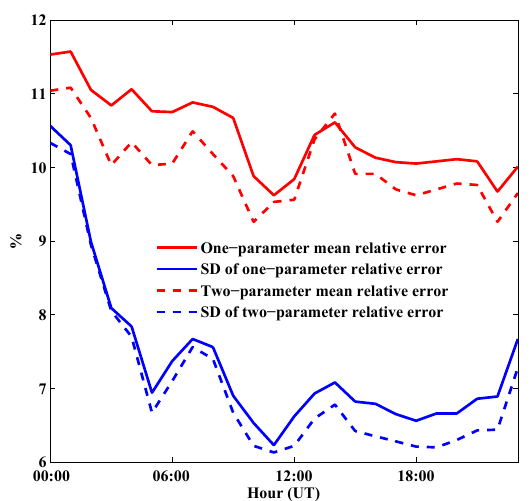
Figure 8. The comparisons between the average relative error and standard deviation of the reconstructed relative error using regular- ization method II and the average relative error and standard devi- ation of the relative error using the single-parameter regularization method under background I